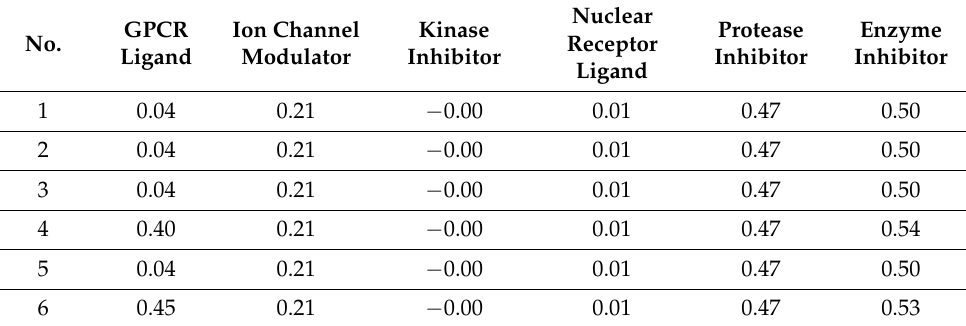
Table 5. The bioactivity score profiles of the selected compounds (1–6) .